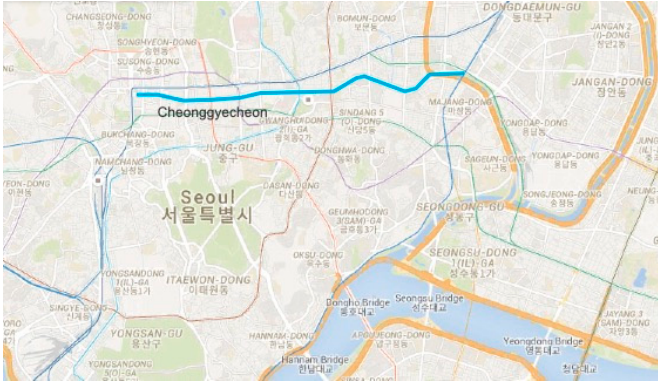
Figure 2. Enlarged map of Seoul with Cheonggycheon highlighted on Google Maps.